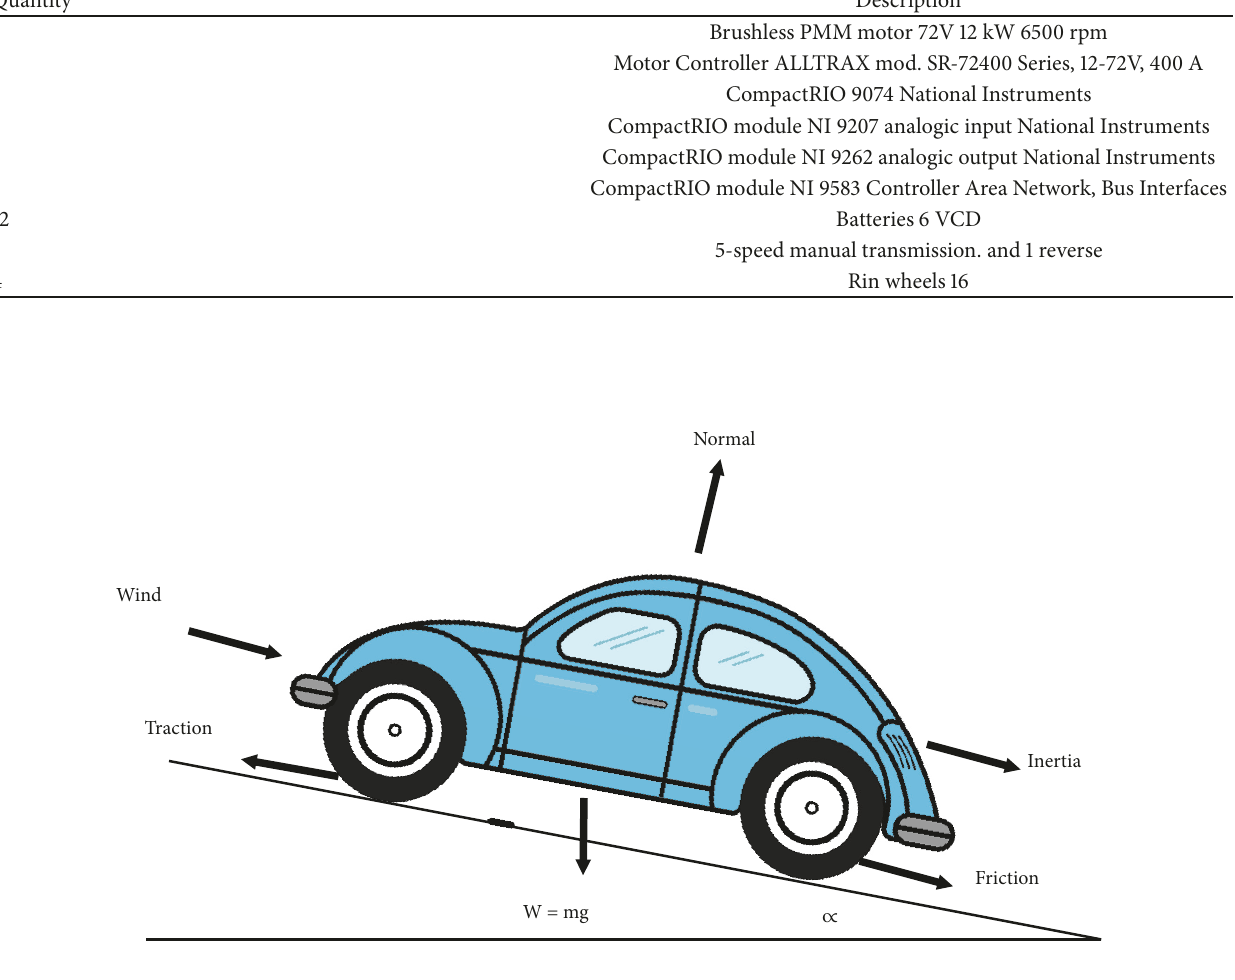
Figure 3: Force analysis. Table 3: Description of model parameters